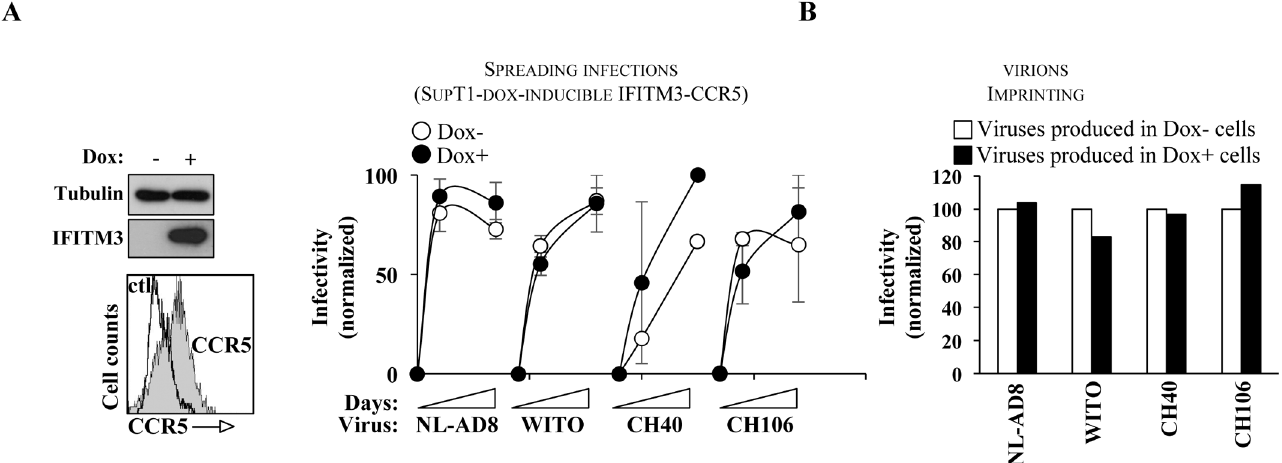
Fig 9. CCR5 usage relievesthe negative effectsof IFITM3 on HIV-1 replication and on its ability to decreasethe virion particles infectivity. A) Human CCR5 was introducedin the IFITM3-stable SupT1 cells used before, by retroviral-mediatedgene transduction and cells were challenged with the indicatedviruses. HIV spreading was assessed by exo-RT activity over time (day 0 through 7). The panels and the histogram overlaypresent the patterns of expressionobtained for IFITM3 and CCR5 followingWB and flow cytometry analyses.The graph presents normalizeddata obtainedin 2 to 3 independent experiments. B) Virions obtainedat late times after infection were harvested, normalized and used to infect HeLaP5cells that containa β -galactosidase reporter gene under the control of the HIV-1 LTR.